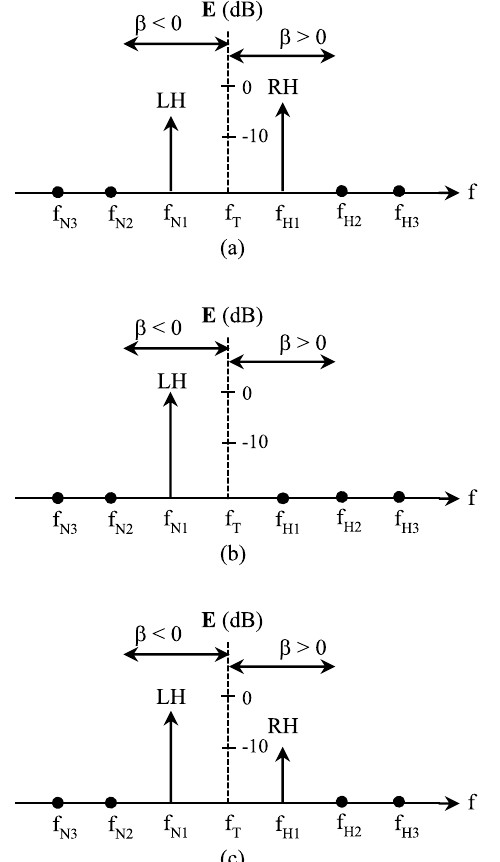
Fig. 13. E Brd j n q ¼ E for round model-N. (a) q =0. (b) q =1. (c) q =